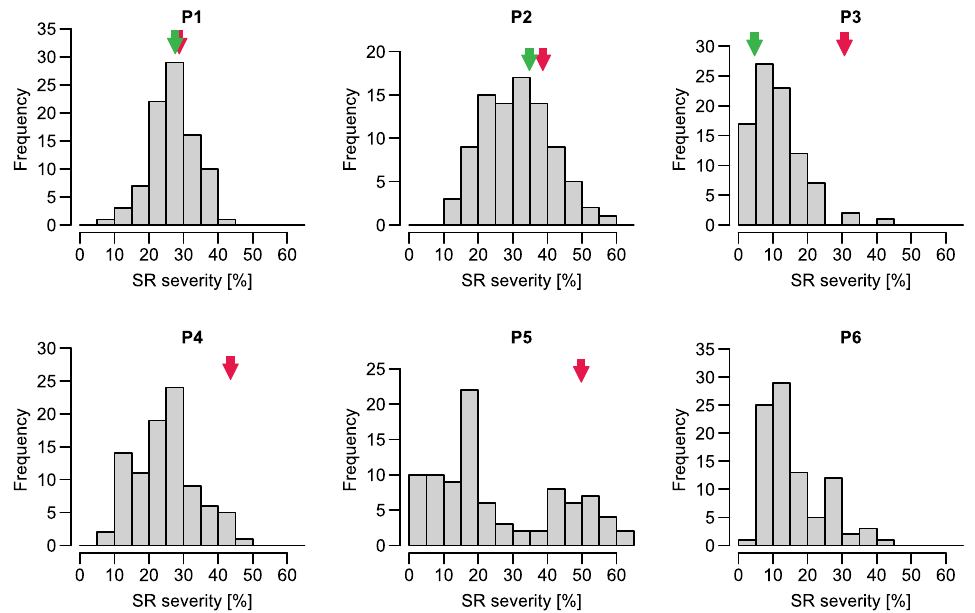
Figure 1. Histograms for populations P1–P6 for stem rust severity. The red and green arrows indicate the value of the susceptible and resistant parent respectively; if not presented, the respective parents of this population were not tested in the field.